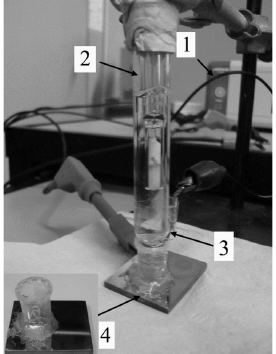
Figure 1. Cell for portable and field analysis: 1 – Potentiostat - galvanostat; 2 – Saturated calomel electrode (SCE); 3 – Counter electrode; 4 – Cell fixed on the surface of the specimen.